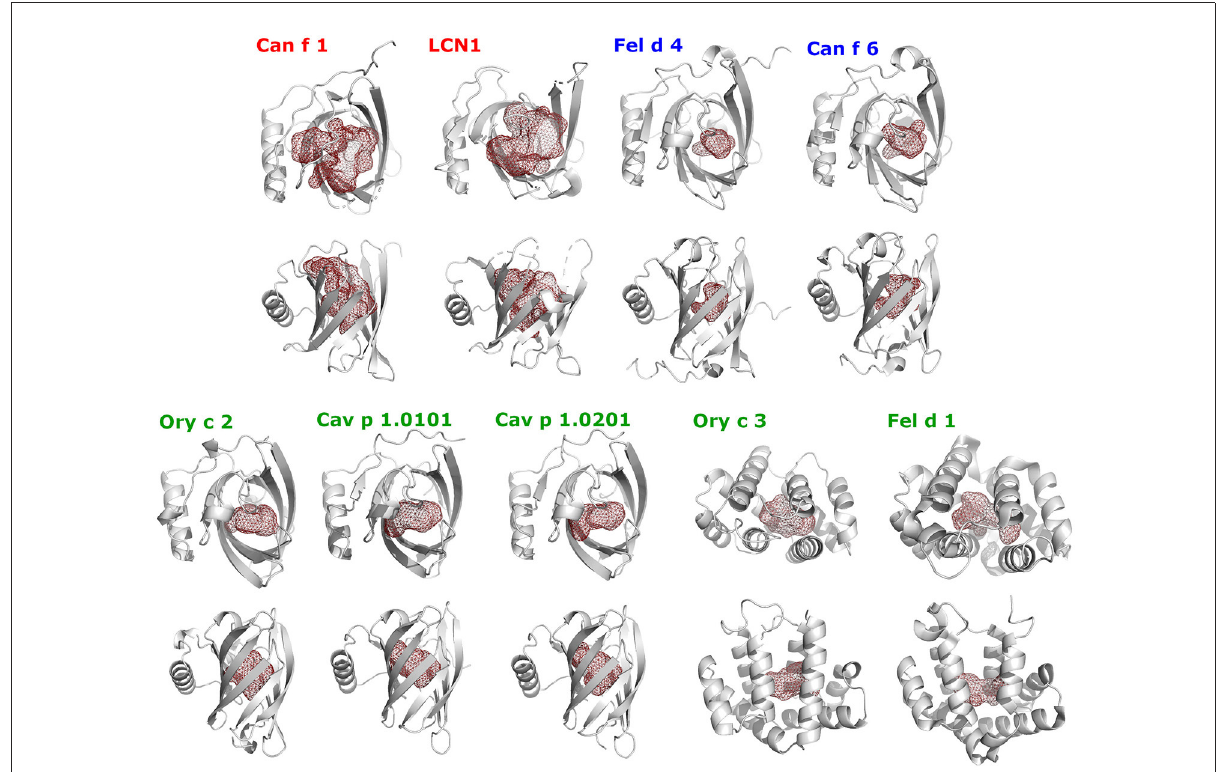
FIGURE11 Shapes of ligand-binding cavities of lipocalin and secretoglobin respiratory allergens and human LCN1. Protein structures are shown as gray cartoons in two perpendicular orientations. The ligand-binding cavities were identified using the CASTp webservice and are represented as red colored mesh structures using